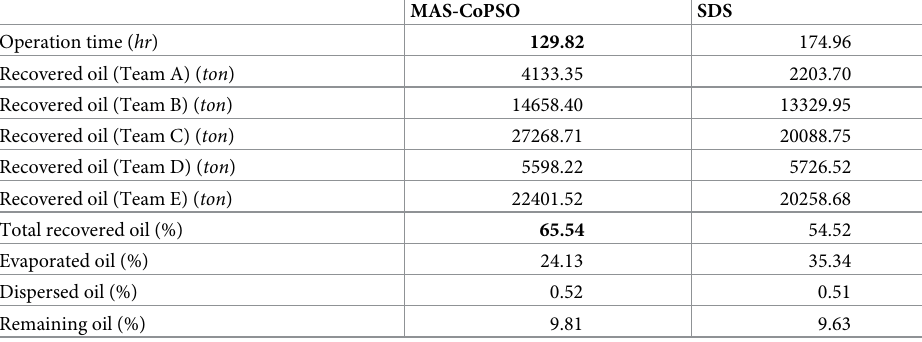
Table 7. Simulation results of MAS-CoPSO and SDS.